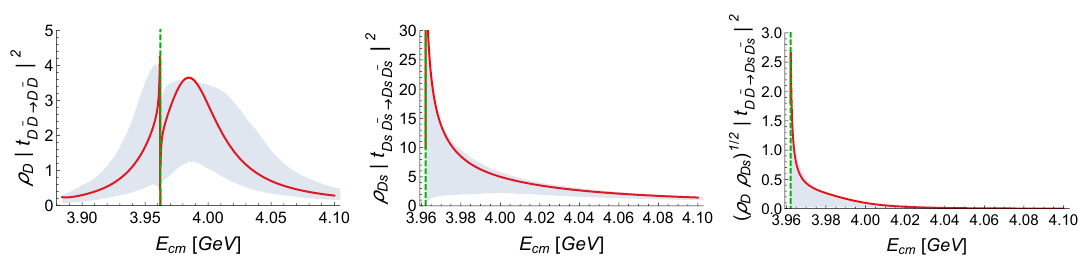
Figure 7 . Coupled channel D ¯ D , D s ¯ D s scattering in partial wave l = 0 . The three plots show √ the quantity ρ i ρ j | t ij | 2 ∝ p | σ | on the physical axes, that is related to the number of events in experiment ( ρ = 2 p/E cm ) for D ¯ D → D ¯ D (left), D s ¯ D s → D s ¯ D s (middle) and D ¯ D → D s ¯ D s (right). The green lines indicate the D s ¯ D s threshold with m D ’ 1981 MeV. The gray bands represent the s uncertainty defined in appendix A.